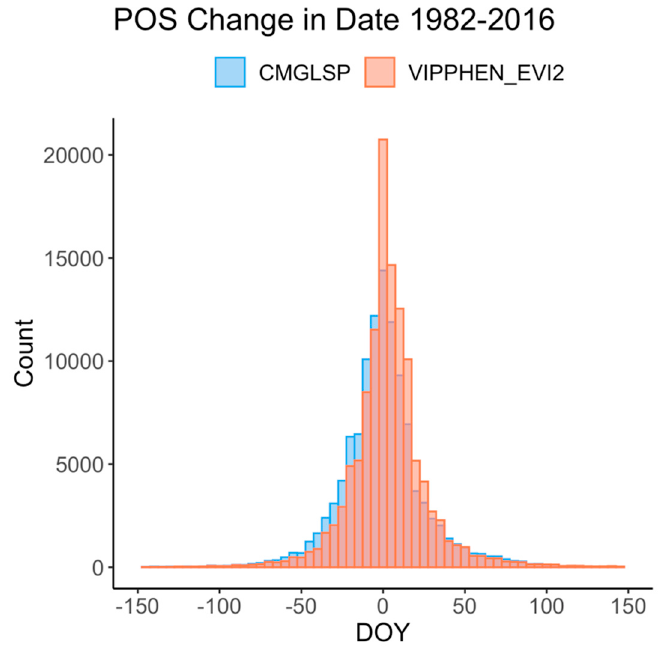
Figure A6. Histogram of CMGLSP and VIPPHEN_EVI2 POS change in date from 1982 to 2016.